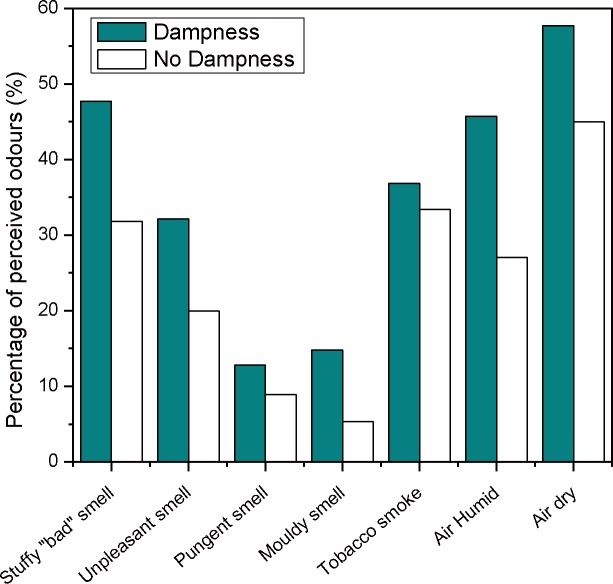
Percentages of homes with different odors, with and without dampness indices, as reported by the parents.